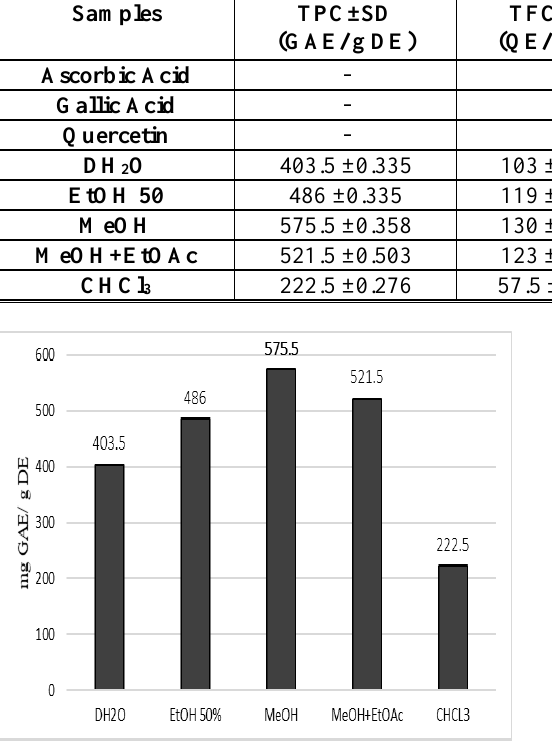
Table 4.TPC, TFC and RSA% of the standards and the extracts.